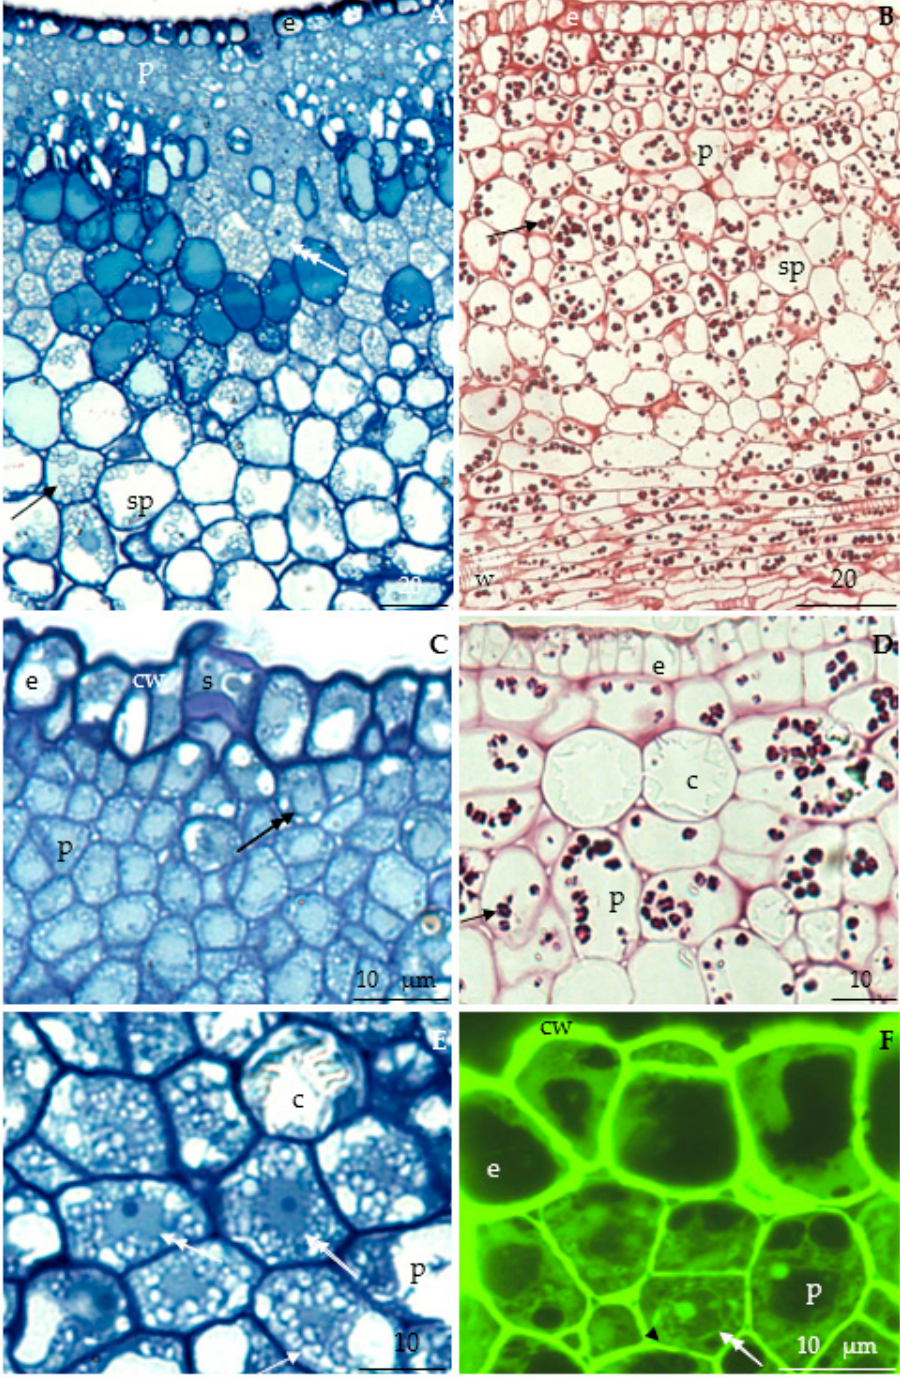
Figure 10. ( A – F ). Fragments of longitudinal sections of nectaries in R. idaeus ‘Glen Ample’ ( A ), ‘Laszka’ ( B ), ‘Radziejowa’ ( C ), ‘Pokusa’ ( D ), ‘Polana’ ( E ), and ‘Polka ( F ) in the initial the secretion phase. ( A , B ): nectary epidermis cells (e), nectary parenchyma (p), subnectary parenchyma (sp), nucleus with a visible nucleolus (three-headed arrow) (photograph A ), numerous amyloplasts (arrow), vascular elements adjacent to the subnectary tissue (w) (photograph ( B )). ( C ): an outer cell wall (cw) thicker than the other epidermis walls (e), stoma (s); visible slight vacuolization of epidermis cells